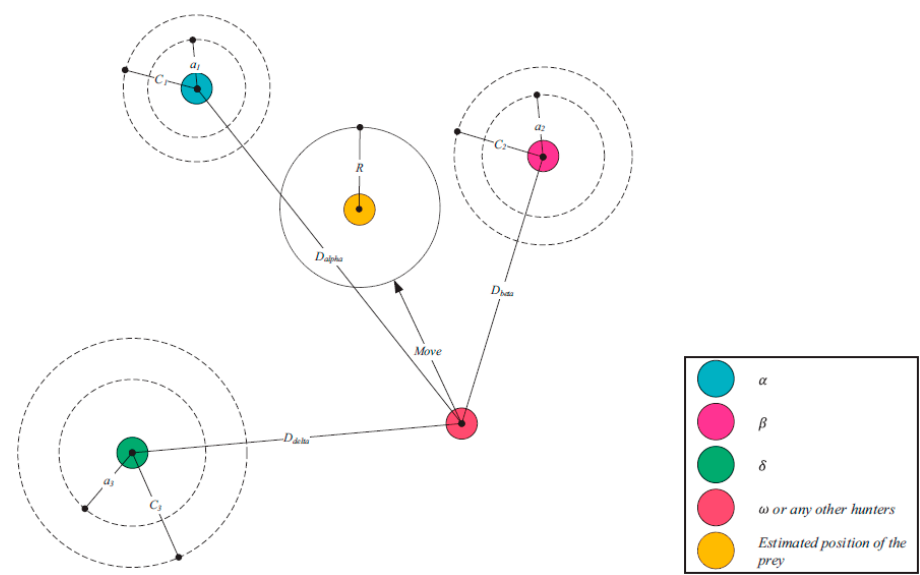
Figure 5. Position updating in GWO.